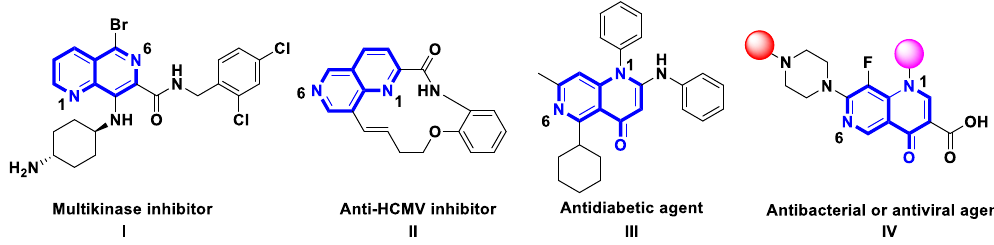
Figure 1. Representative 1,6-naphthyride- or 1,6-naphthyridin-4-one-based pharmacologically active compounds.